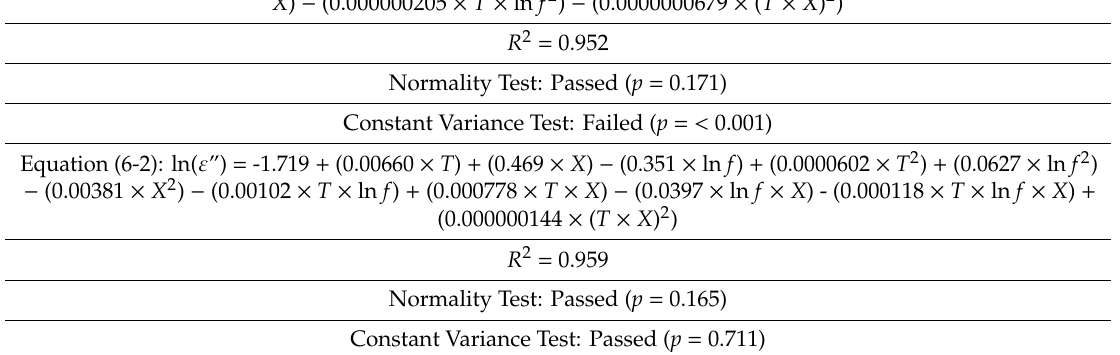
Table 6. The relationship between the dielectric properties and the influencing factors and statistical criteria established by regression analysis for macadamia nut kernels. Equation (6-1): ln( ε (cid:48) ) = 1.467 − (0.000659 × T ) + (0.102 × X ) − (0.119 × ln f ) + (0.0000327 × T 2 ) + (0.0170 × ln f 2 ) +